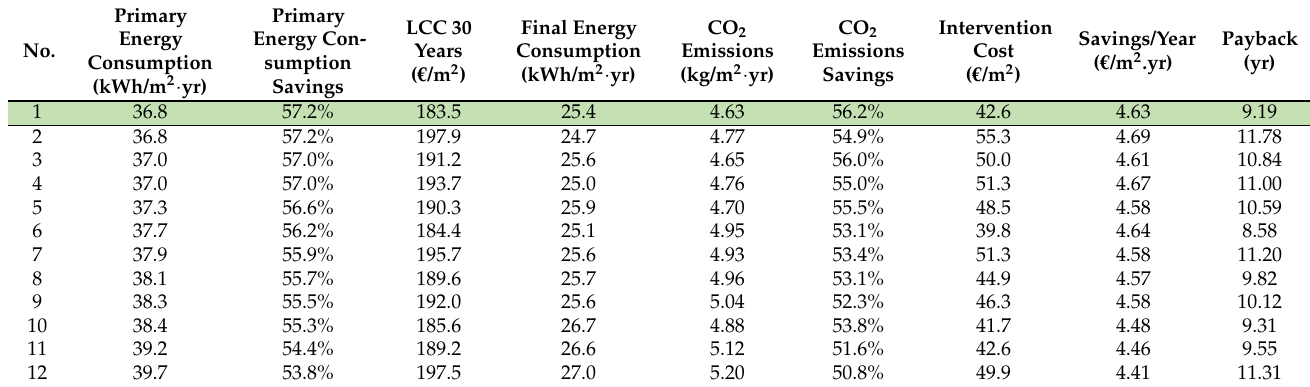
Table 6. POS results.